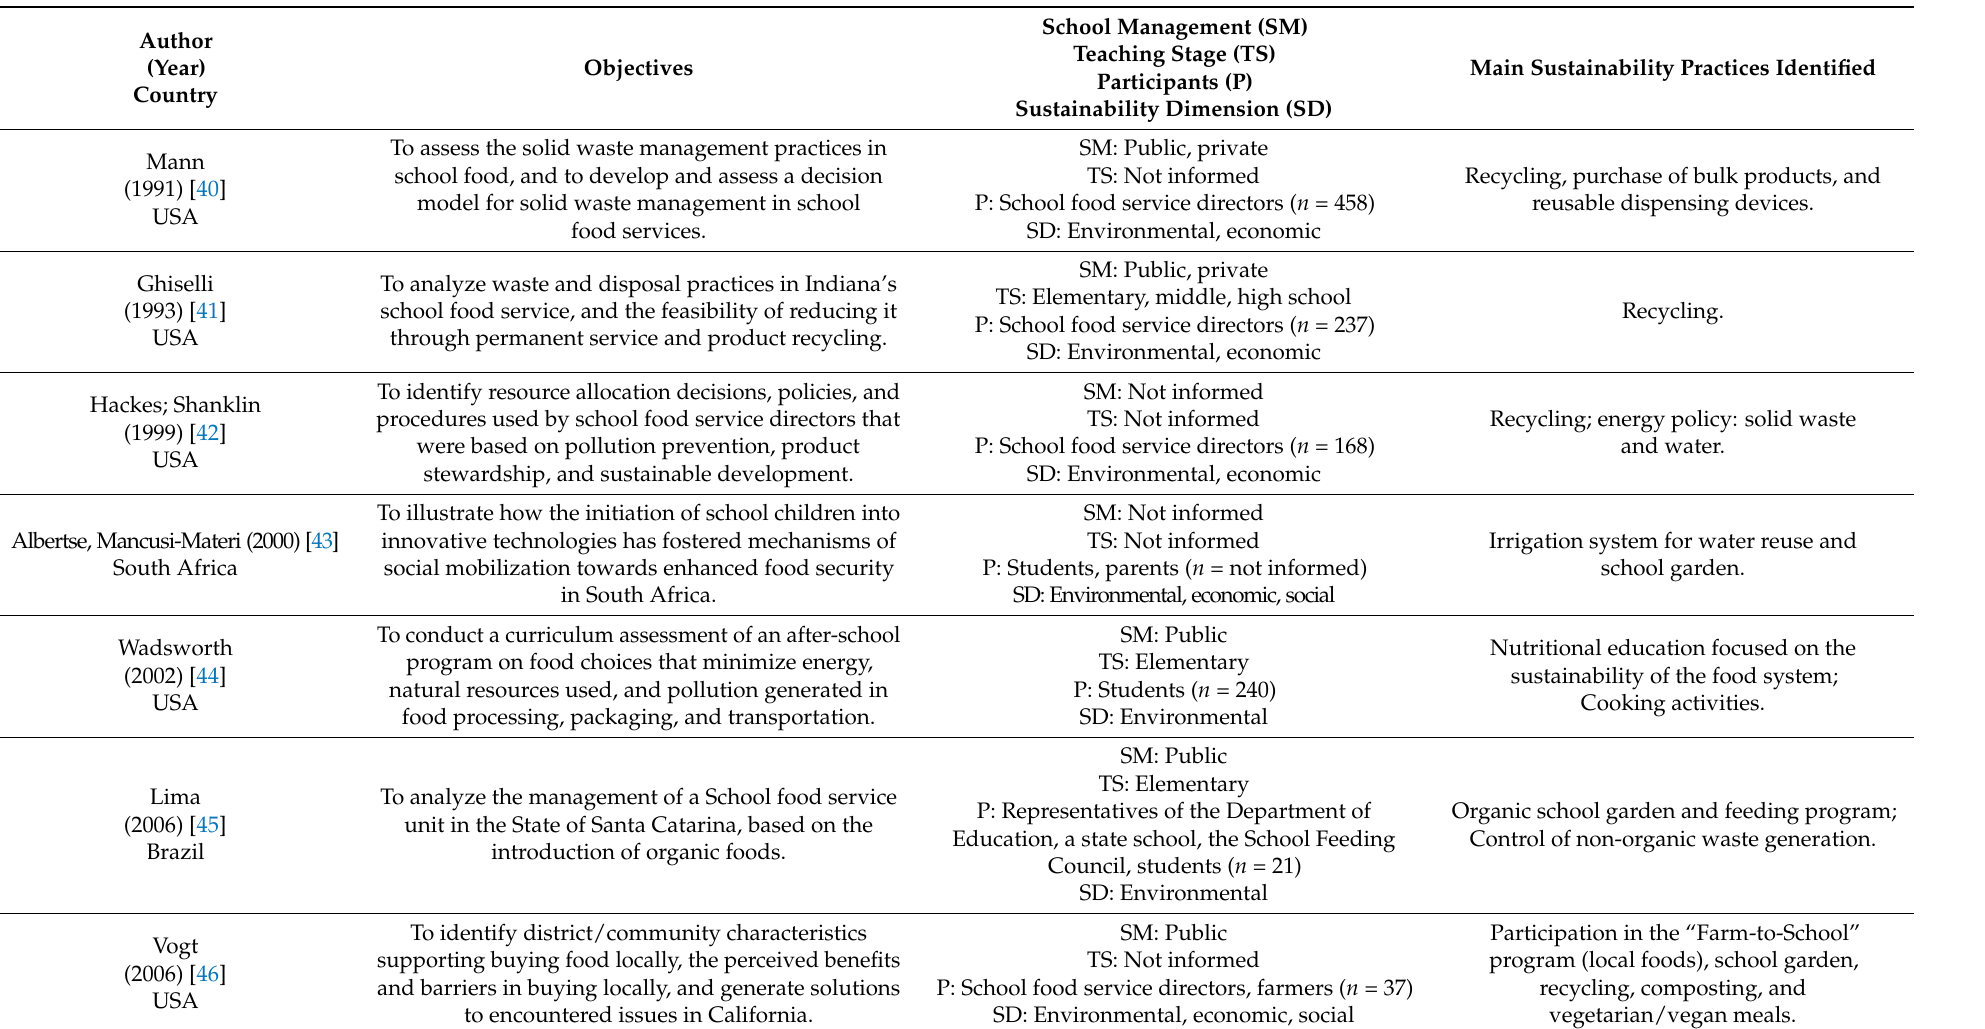
Table 1. Main descriptive characteristics and results from the included